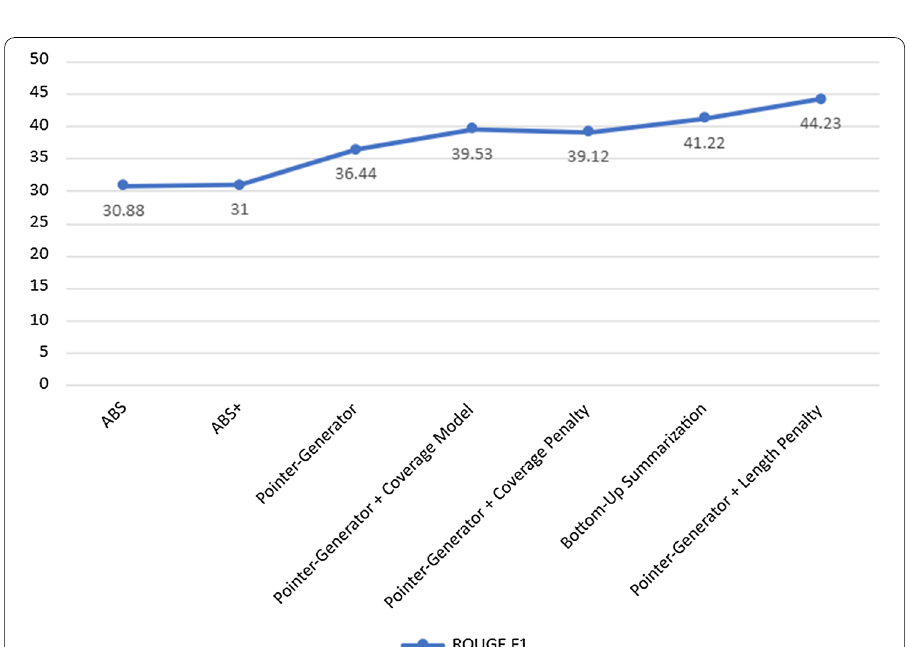
Fig. 8 ROUGE F1 results comparison between abstractive summarizers on different